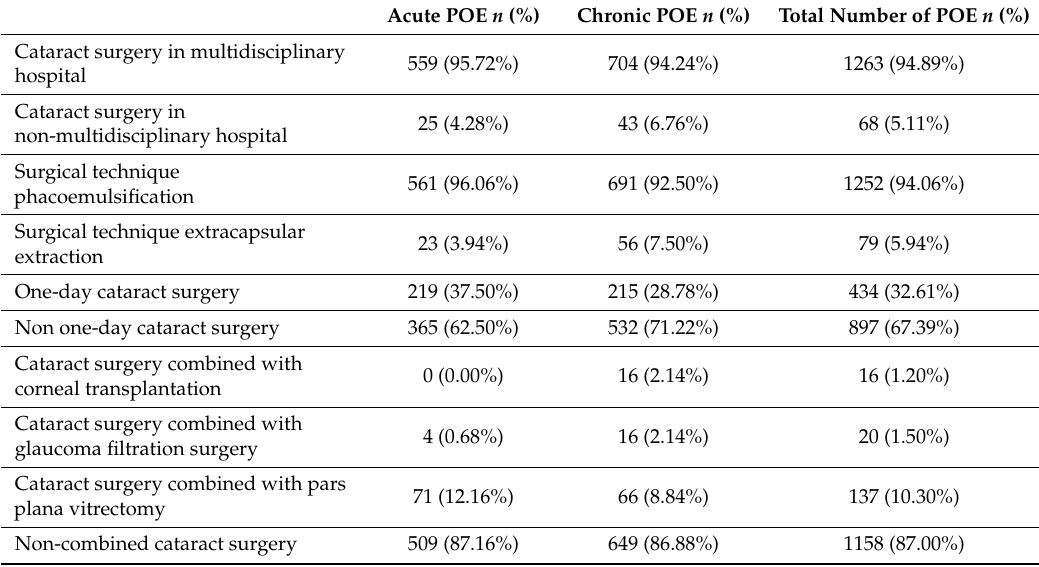
Table 4. Surgical characteristics of all postoperative endophthalmitis (POE) cases after cataract surgery in Poland during